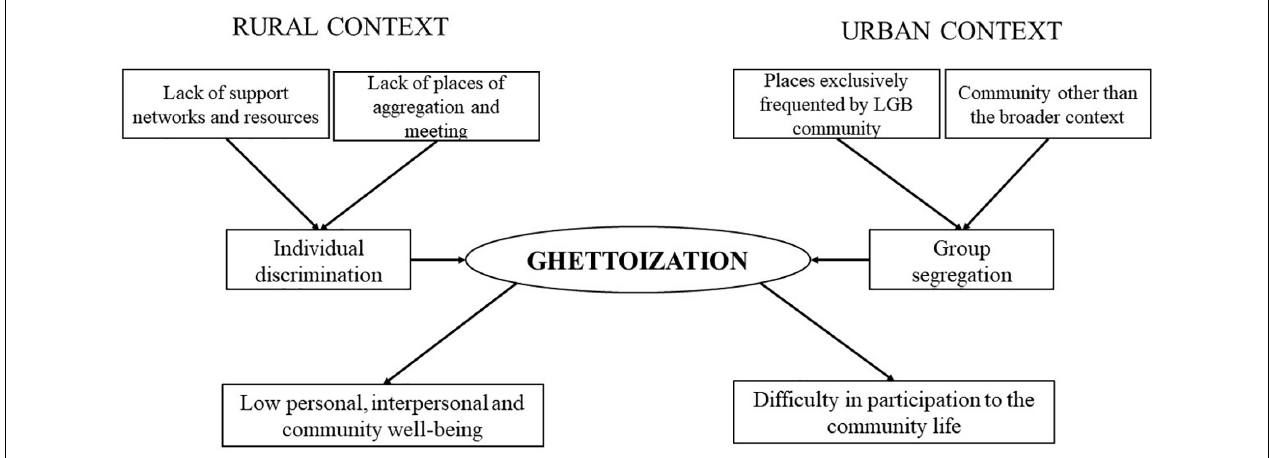
FIGURE 1 | Core category,